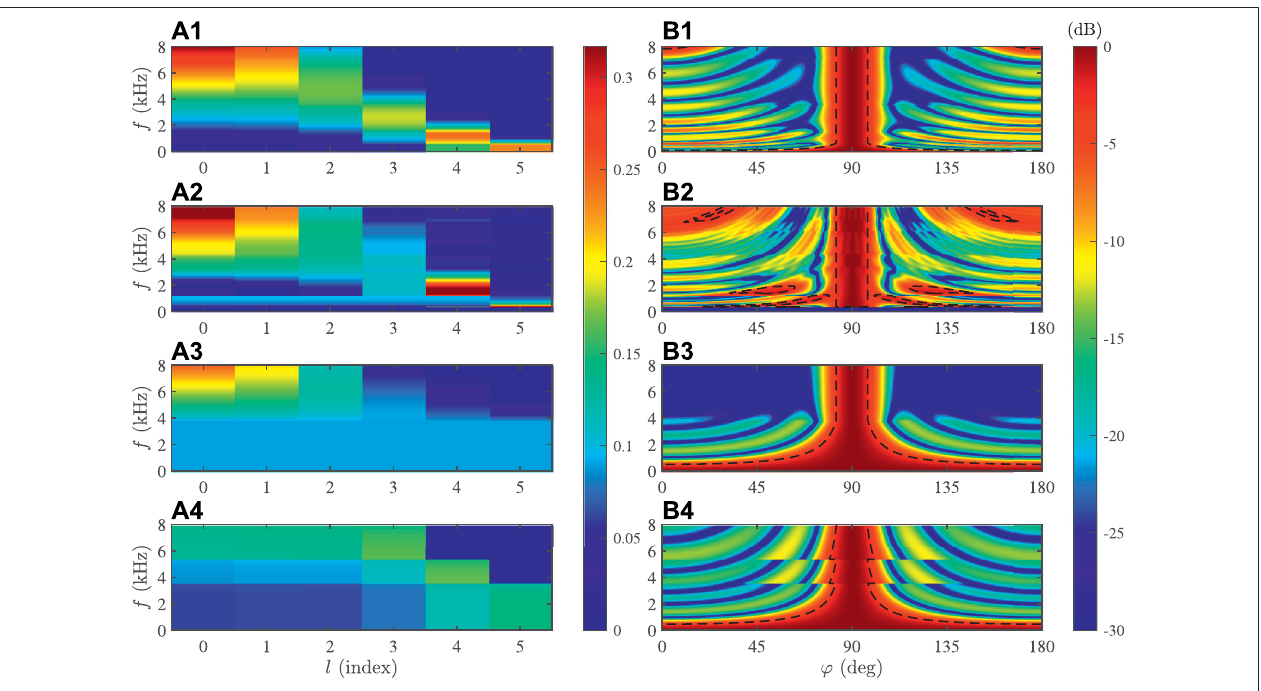
FIGURE 3 | The left subplots (A) illustrate the weight values of the arrays: (1) proposed, (2) Son, (3) Long, and (4) Ward. For each array, the weights are given per sensor as a function of frequency. The right subplots (B) illustrate the beampatterns. The overlayed dashed line is the half-power contour of the mainlobe.